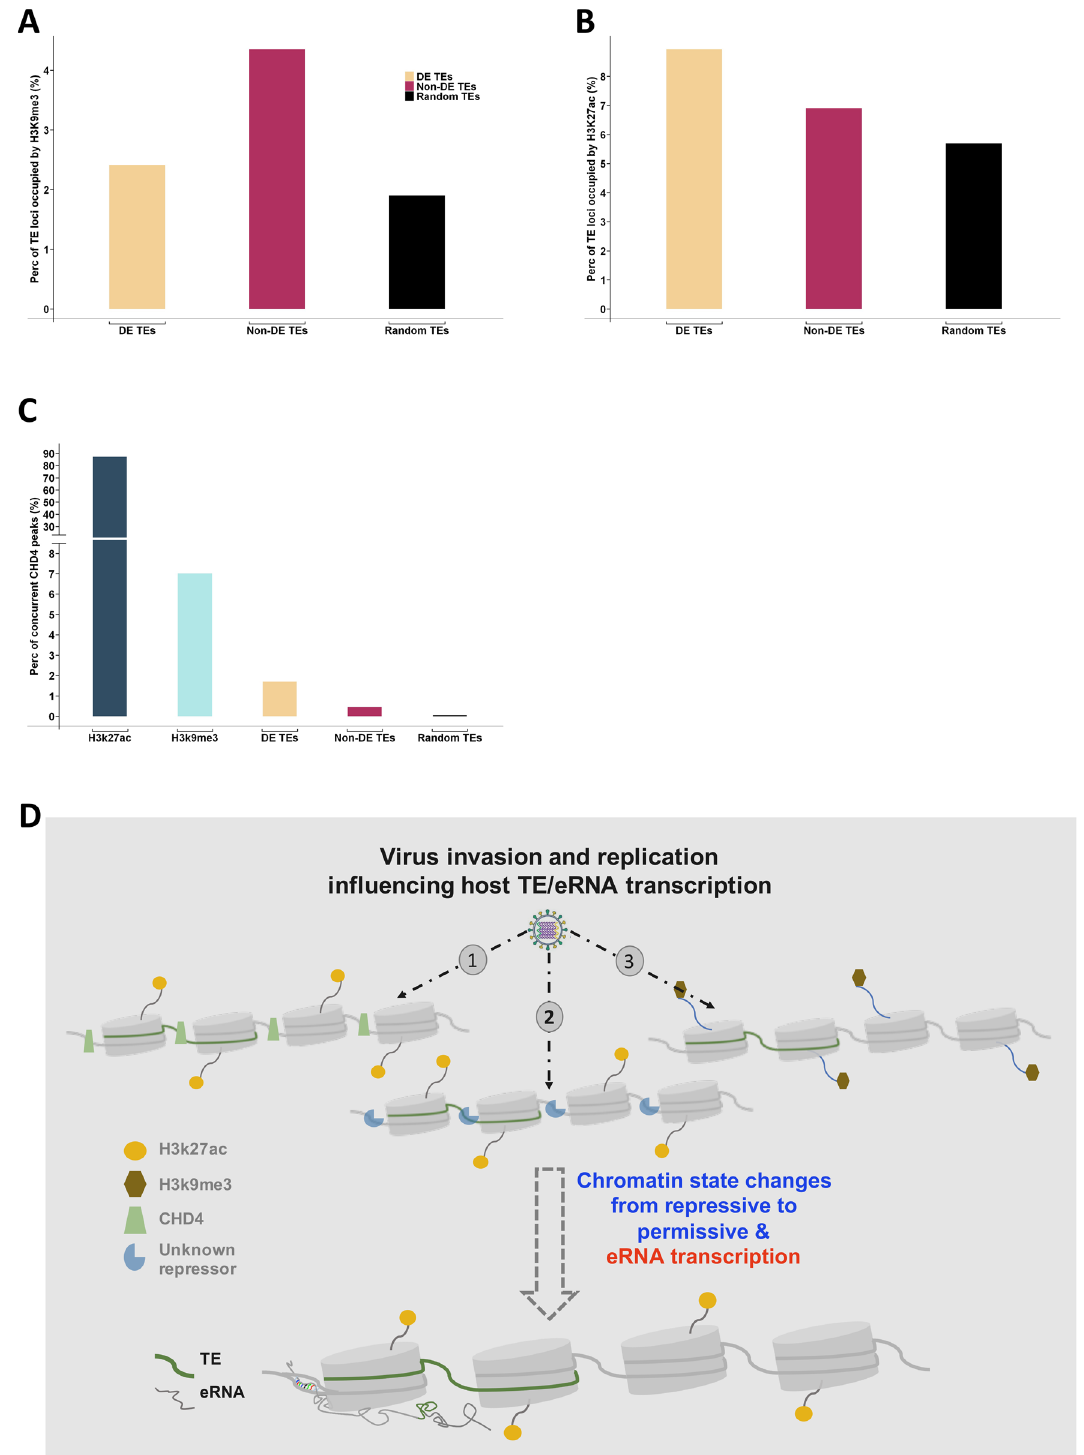
Figure 5. Chromatin accessibility in transposon regions in uninfected A549 cells. ( A ) the number of H3k9me3 occupied non-DE TEs is about twice higher than DE TEs, which suggest IAV likely impacts on TE regions with less H3k9me3 occupancy. ( B ) the DE TEs tends to be derived from H3k27ac occupied TE regions in contrast to non-DE TEs and random controls. ( C ) majority of CHD4 binding regions are H3k27ac occupied. ( D ) A putative model illustrating how virus may interact with the host to change chromatin status, leading to activation of poised or silent